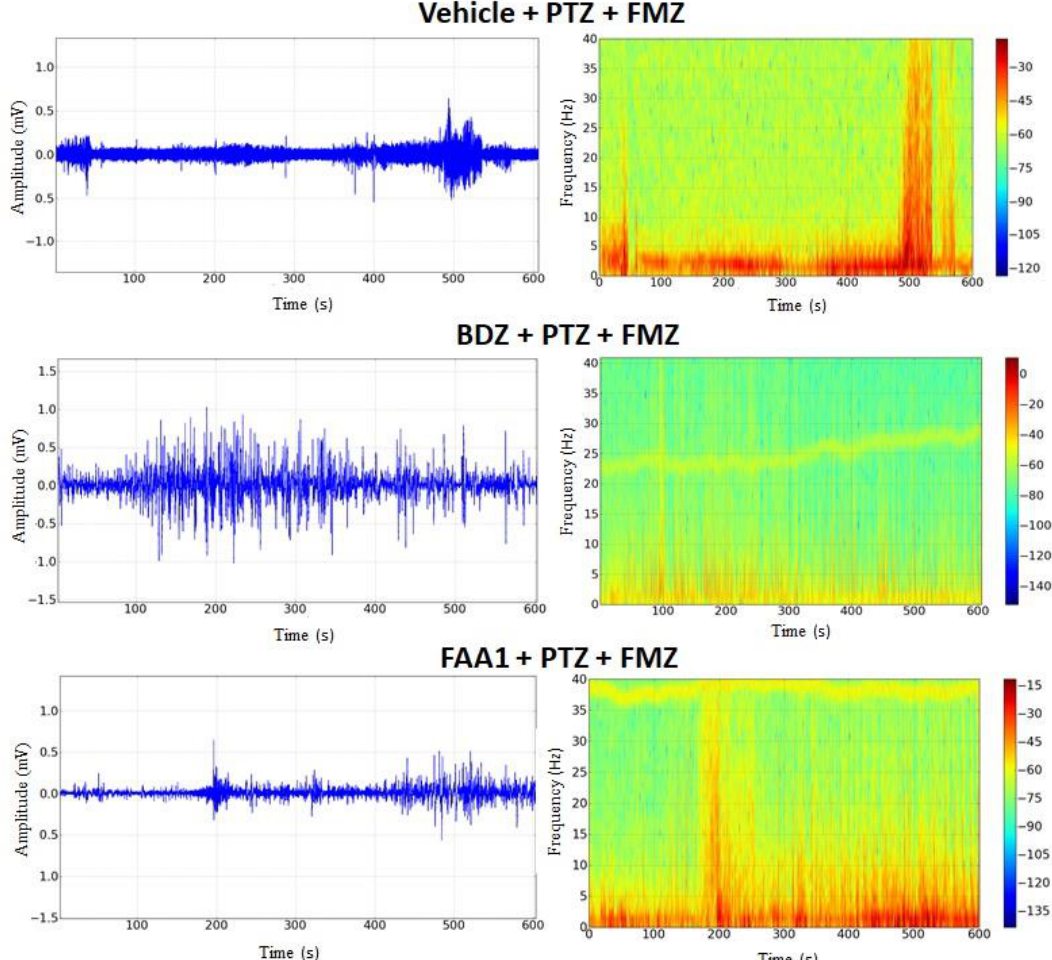
Figure 8. Electrocorticographic tracing and spectrogram recordings after flumazenil administration in control (FMZ) and treated groups with BDZ (5 mg/kg) and FAA1 (300 mg/kg), 10 min after seizure induction with PTZ (60 mg/kg). Recordings made for 600 s.